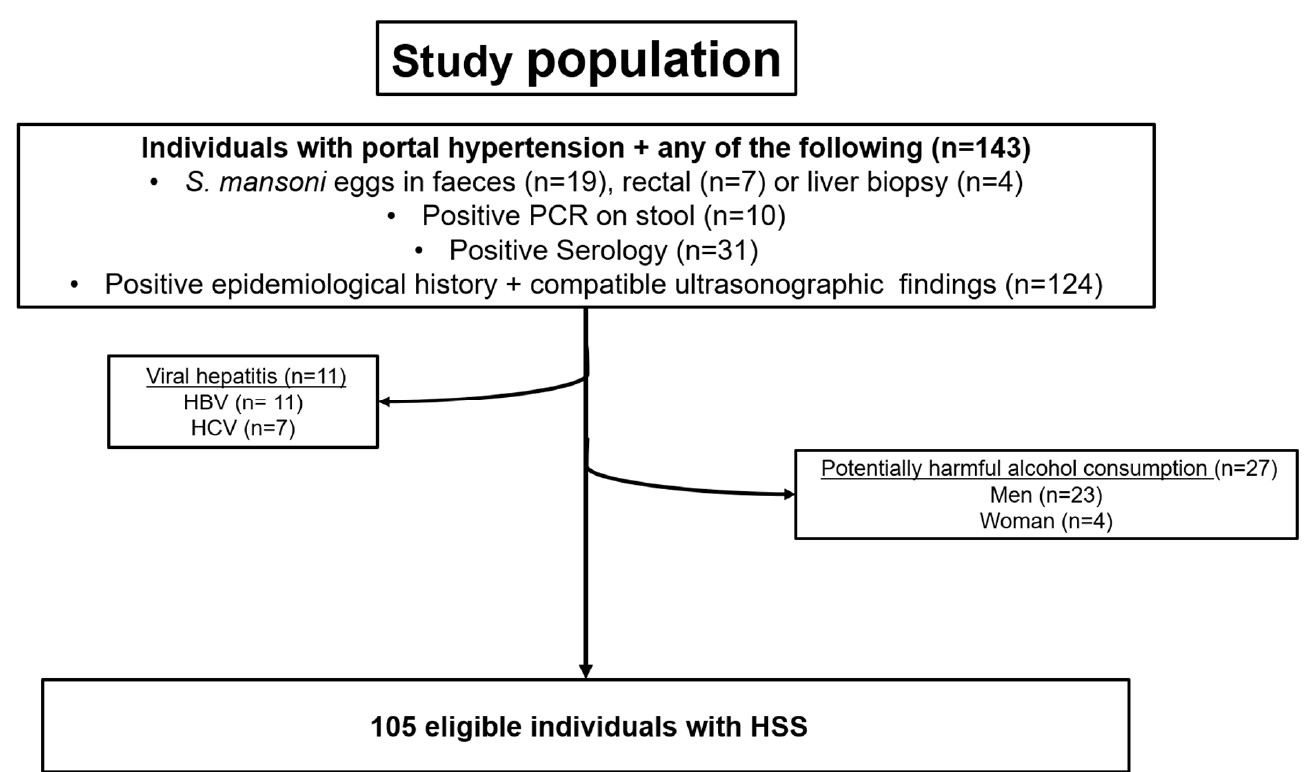
Figure 1. Study population. Frequencies in the first box (individuals with portal hypertension + any of the following) are not cumulative, as patients could have more than one of diagnostic